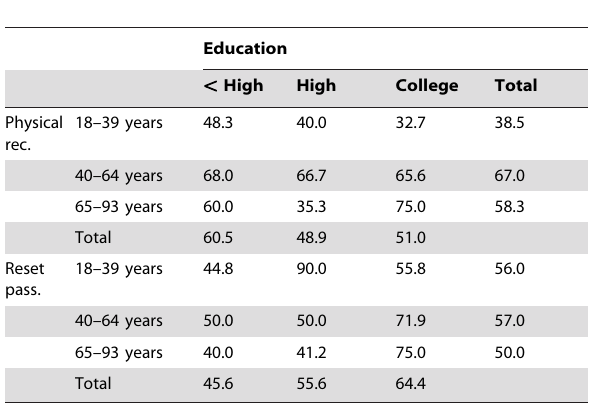
Table 6. Percentage of participants reporting keeping physical records of passwords and having to reset passwords according to age and